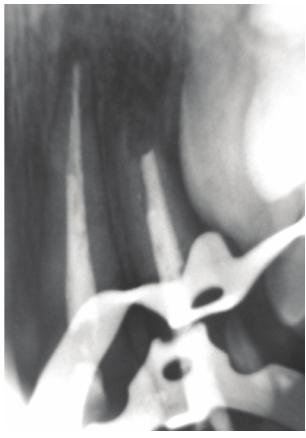
Figure 4: Periapical radiograph after 1 year of starting treatment showing the apical barrier formation after 8 months (seventh session; March 1999).